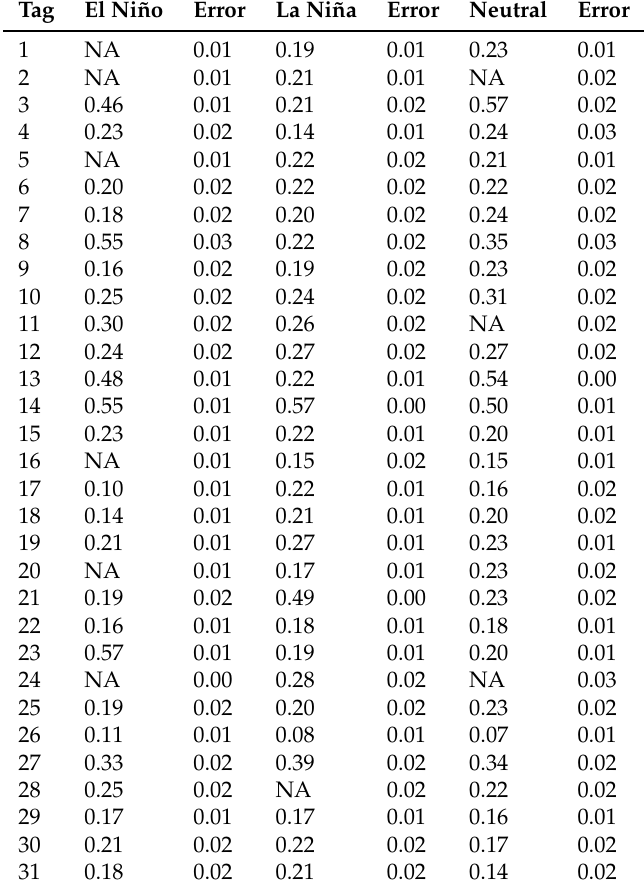
Table A2. The DFA coefficient ( α ) of solar radiation between twenty seven hours and ten days.